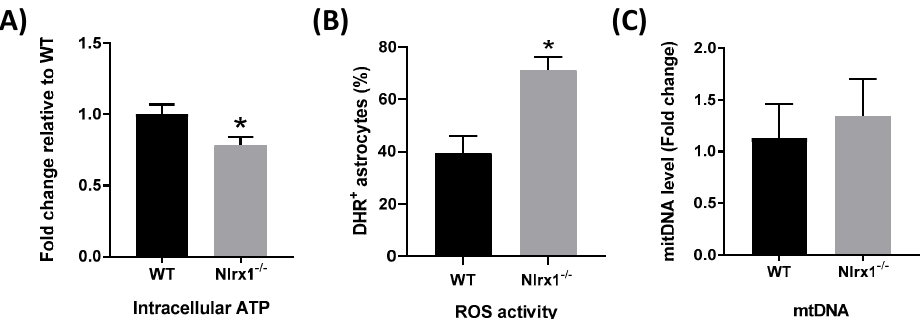
Figure 5. NLRX1 enhances mitochondrial functions in astrocytes. ( A ) The level of intracellular ATP was measured in WT and Nlrx1 - / - astrocytes using an ATP bioluminescent assay kit ( n = 5); ( B ) the level of oxidative activity was measured in WT and Nlrx1 - / - astrocytes by flow cytometry ( n = 4); ( C ) the di ff erence between the amount of mtDNA in WT and Nlrx1 - / - astrocytes was measured by qPCR ( n = 3). * p < 0.05 as determined by Mann–Whitney test, results are presented as mean ± SEM.